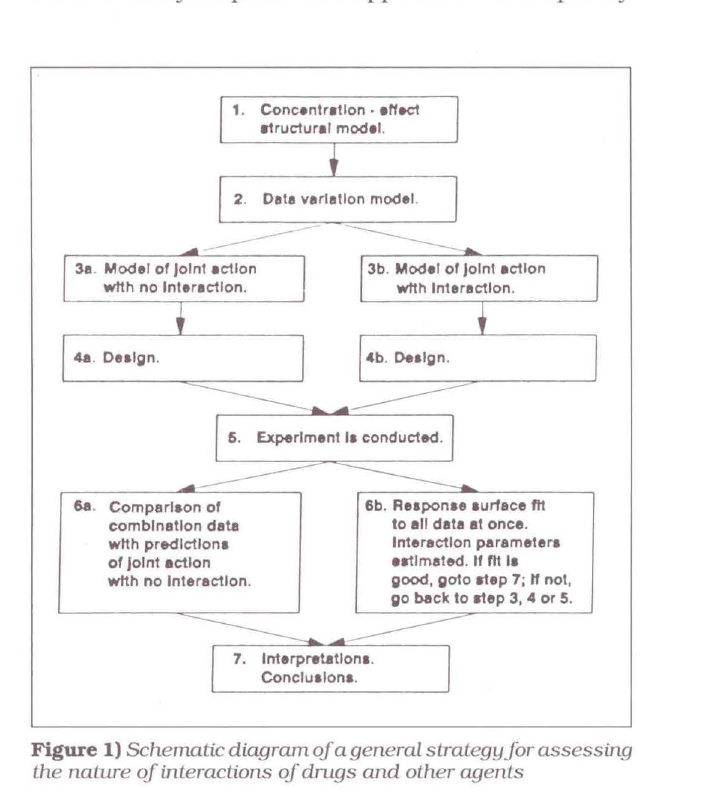
Figure 1) Schematic diagram of a general strategy for assessing the naLW"e of interactions of drugs and other